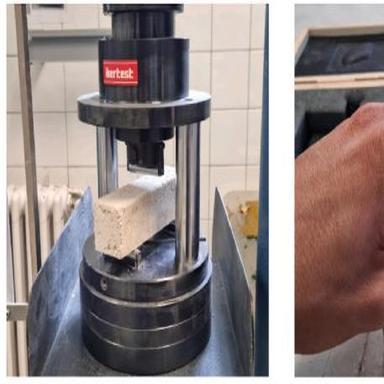
(a) Bending test; (b) Surface hardness test.